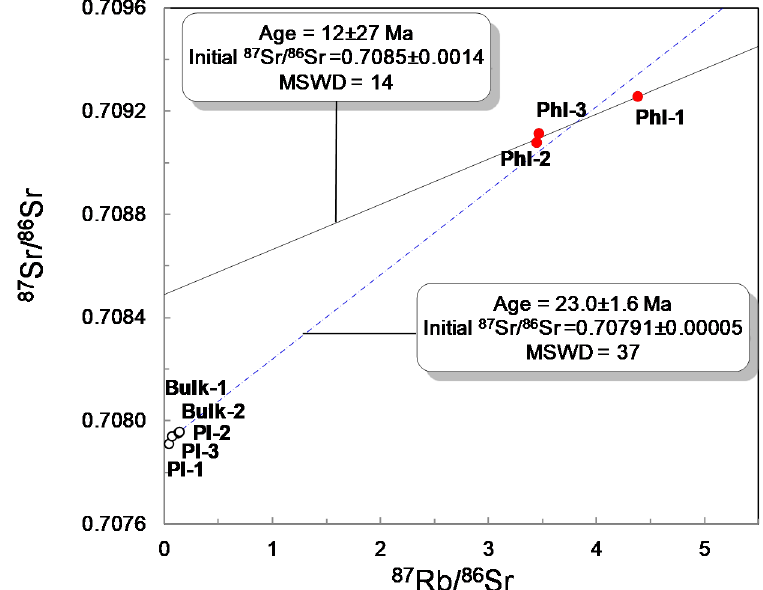
Figure 13. Two Rb–Sr errorchrons showing the ages of ruby-bearing rock at Snezhnoe (blue dotted line), with a likely alteration process affecting the Rb–Sr system in phlogopite (black solid line). The epsilon notation value ε Nd (20Ma) for the bulk ruby-bearing rock was about − 9.6 (Table